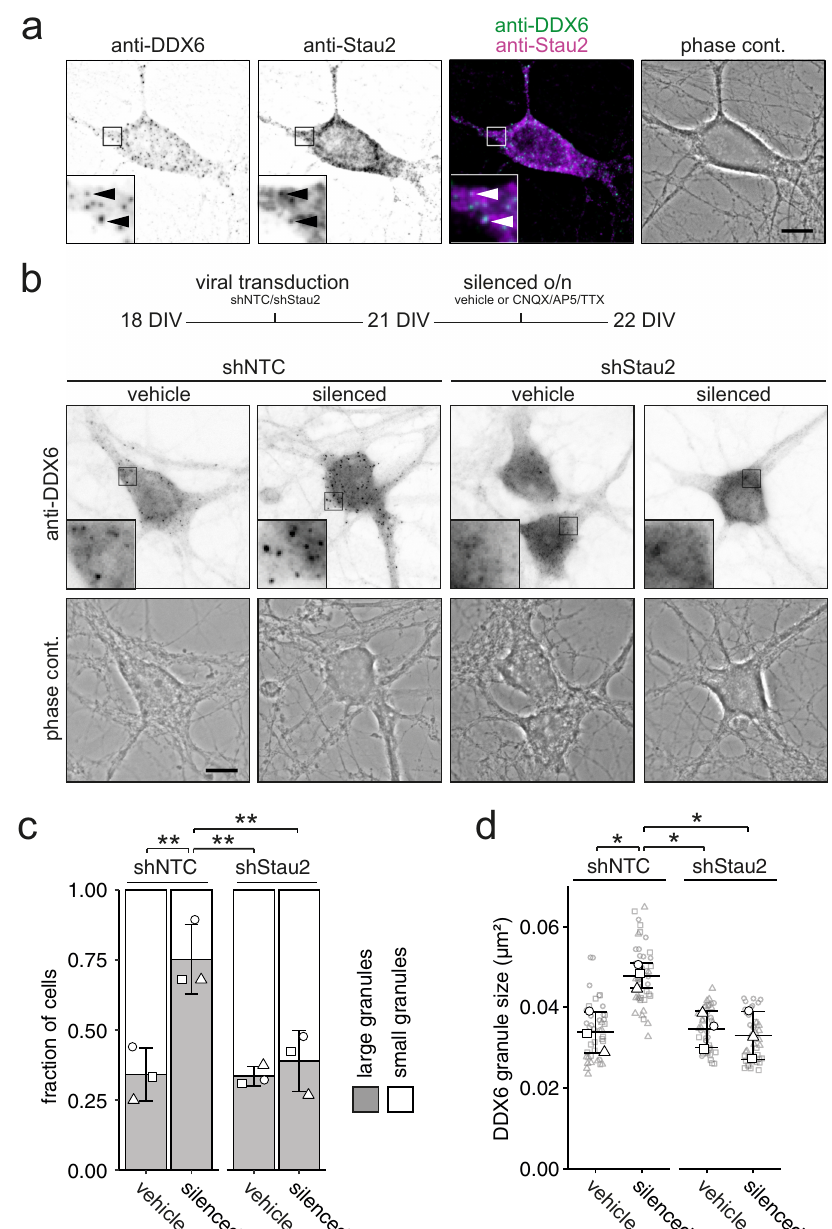
Fig. 3 Stau2 depletion inhibits DDX6 granule assembly upon neuronal inhibition. a Representative example of DDX6 and Stau2 immunostaining, merge and phase contrast pictures of a 22 DIV hippocampal neuron. Arrowheads indicate instances of co-localization. b Experimental outline and representative examples of DDX6 immunostainings and phase contrast pictures of shNTC and shStau2 transduced 22 DIV hippocampal neurons in culture either under vehicle (DMSO) treated or silenced (100 µ M CNQX, 50 µ M AP5, 1 µ M TTX) conditions. Boxed regions in images are displayed as magni fi ed insets. Scale bars 10 µ m. c Bar plot displaying quanti fi cation of cell population by fraction of cells containing either large or small DDX6 granules as exempli fi ed in b . Distinct dot symbols indicate biological replicates. At least 100 cells/condition/experiment were quanti fi ed. d Dot plot displaying average DDX6 granule size of individual cell bodies. Small gray symbols represent single cells while larger white symbols indicate the average of each replicate. Data represents mean ± standard deviation of three independent neuronal cultures. Asterisks represent p -values obtained by Tukey ’ s test post-hoc to two-way ANOVA analysis (* p < 0.05, ** p < 0.01). F 1,8 = 0.00316, Stau2 depletion ( c ); F 1,8 = 0.0110, neuronal inhibition ( c ), F 1,8 = 0.0336, Stau2 depletion ( d ); F 1,8 = 0.0530, neuronal inhibition ( d